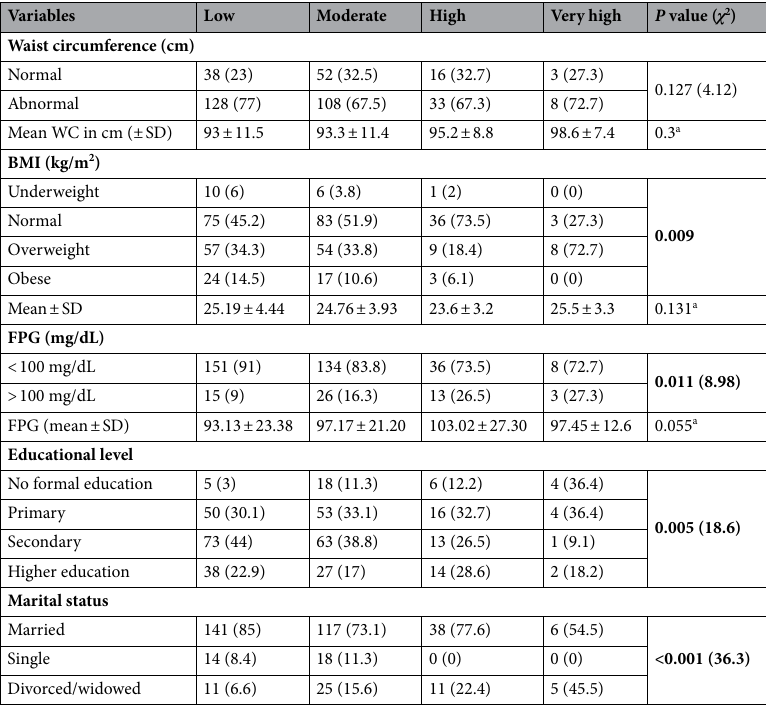
Table 7. Relationships between 10-year risk for cardiovascular risk (according to Framingham risk score) and selected variables. Significant values are in bold. WC waist circumference, BMI body mass index, FPG fasting plasma glucose. a